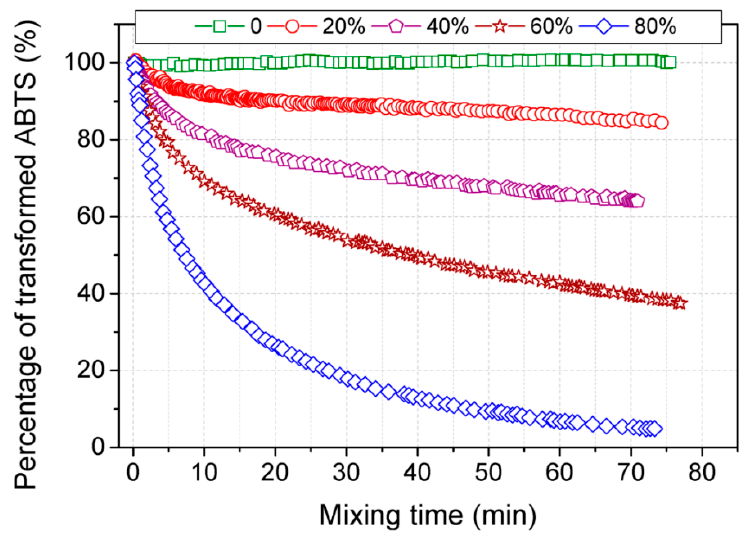
Figure 2. Effects of acetone content on kinetic transformation of ABTS radicals.